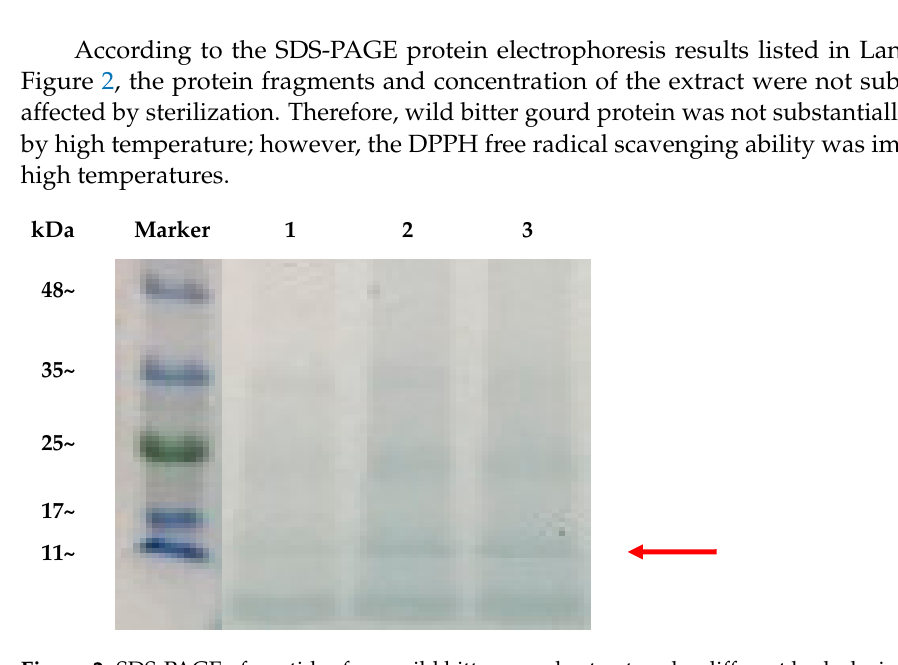
Table 4. Mold and yeast count of wild bitter gourd extract treated by different methods. Mold and Yeast Colonies Extract from Wild Bitter Gourd